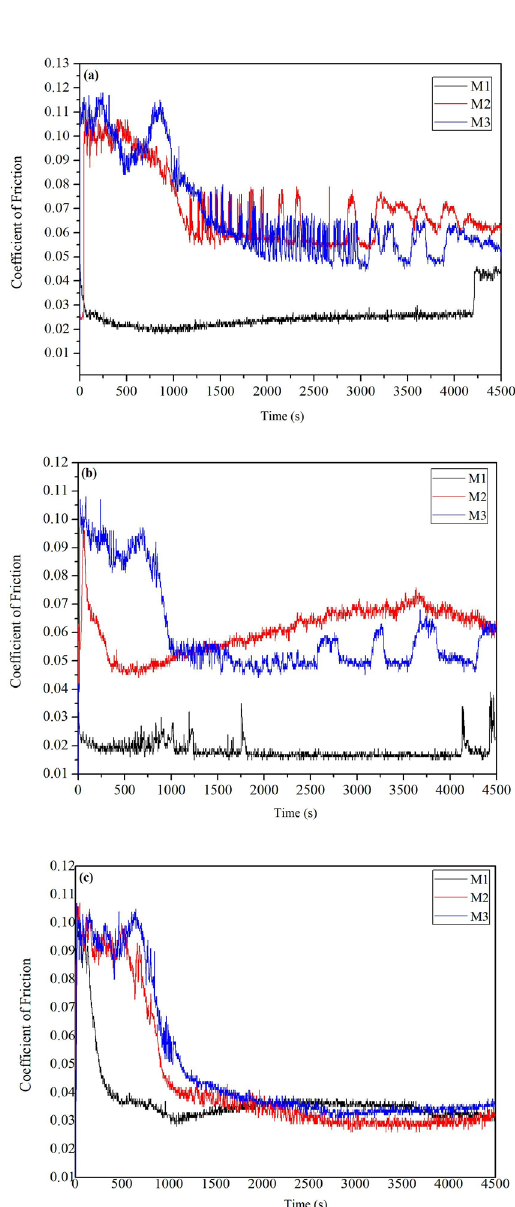
Figure 7. Behavior of the coefficient of friction for microemulsion systems using surfactants: (a) NP4EO, (b) NP6EO and (c)